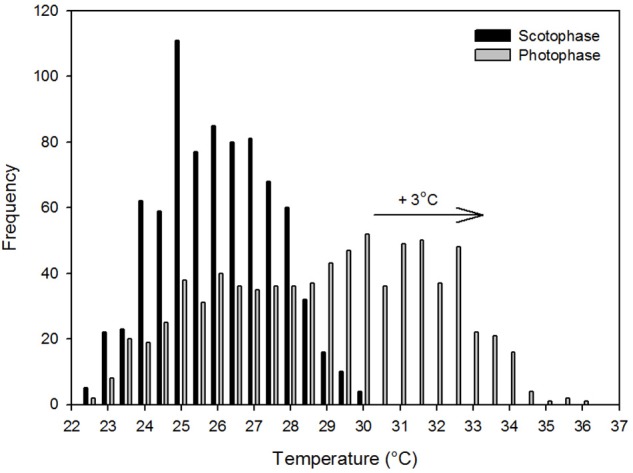
The frequency distribution of the scotophase and photophase ambient temperatures recorded within the forest at Sama Jaya Nature Reserve from 00:00 24th June 2015 to 00:00 27th July 2015. The arrow indicates the commonly predicted shift of three degree Celsius in the modal temperature associated with global warming.